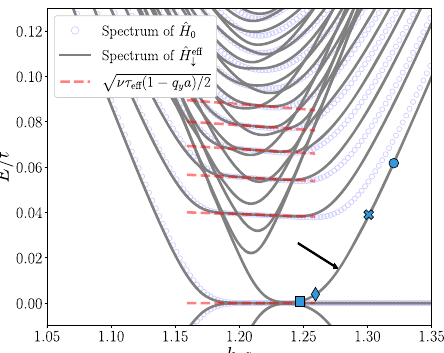
Fig. 6 Energy spectrum for the Thomas – Fermi regime. Spectrum of ^ H eff when the Bose – Einstein condensate of ↑ atoms is in the Thomas – Fermi regime, including a comparison with the spectrum of the strained graphene Hamiltonian ^ H (empty circles) and the Landau levels predicted by Eq. (9) 0 (dashed lines). The number of sites along x is N x = 601, the onsite interaction is U = 10 − 4 J , the strength of the harmonic trap is V x = 10 − 6 J / a 2 , the number of condensed bosons is N ↑ = 1.2 × 10 5 , and the interspecies interaction strength is α = 0.3. The strain intensity is τ eff = 0.003. The four dots with different markers correspond to representative eigenstates of the energy branch indicated by the arrow that will be shown in a separate fi